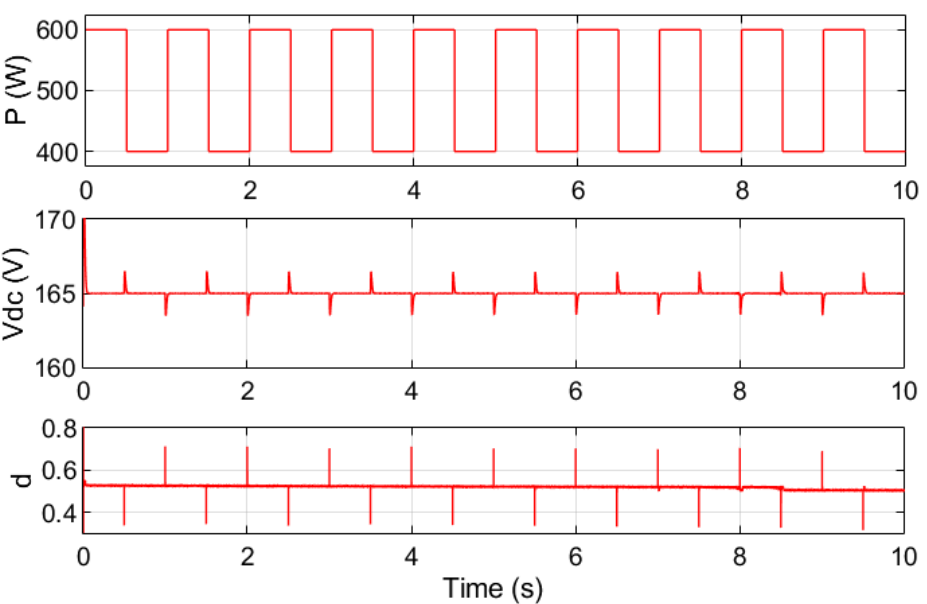
Figure 8. Simulation results under a square wave change of the CPL.